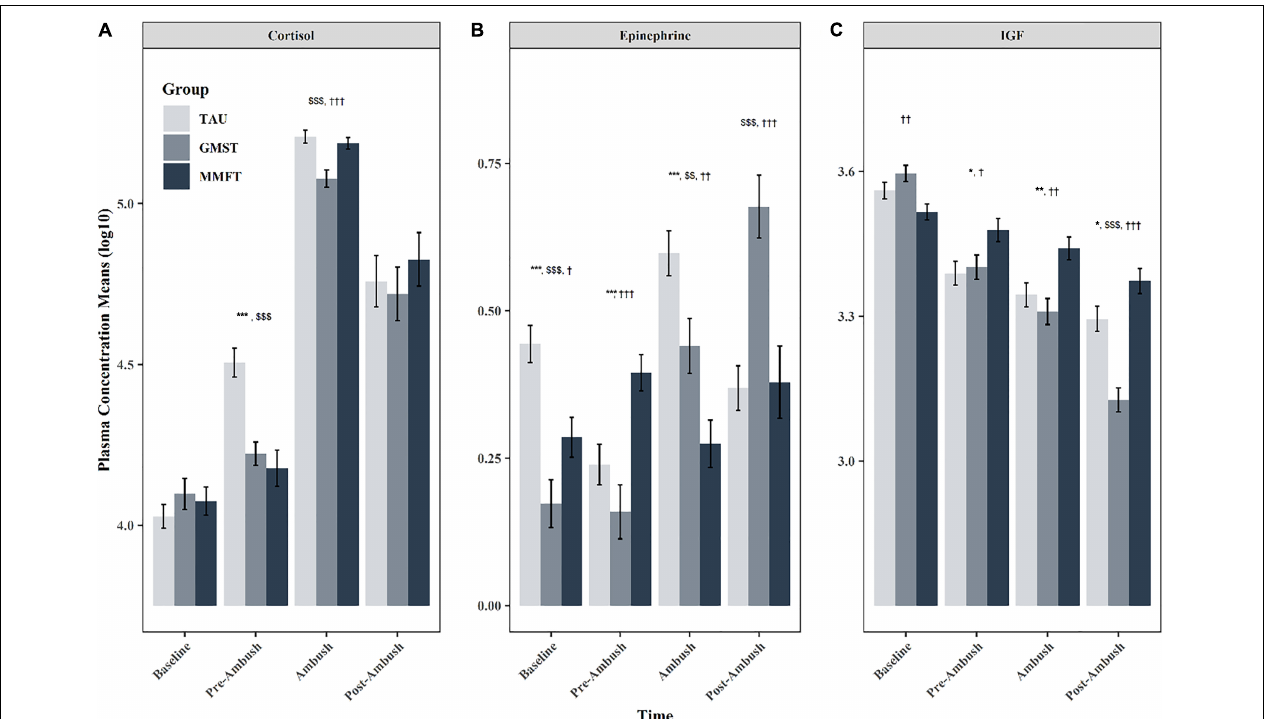
FIGURE 3 | Log10 transformed means for (A) Cortisol, (B) Epinephrine, and (C) IGF-1 comparing the differences between GMST, MMFT, and TAU. Error bars represent one standard error above and below the mean. ∗ indicates significant adjusted contrast comparing TAU to MMFT. ∗ p < 0.05, ∗∗ p < 0.01, ∗∗∗ p < 0.001. † indicates significant adjusted contrast comparing GMST to MMFT. † p < 0.05, †† p < 0.01, ††† p < 0.001. $ indicates significant adjusted contrast comparing TAU to GMST. $ p < 0.05, $$ p < 0.01, $$$ p <